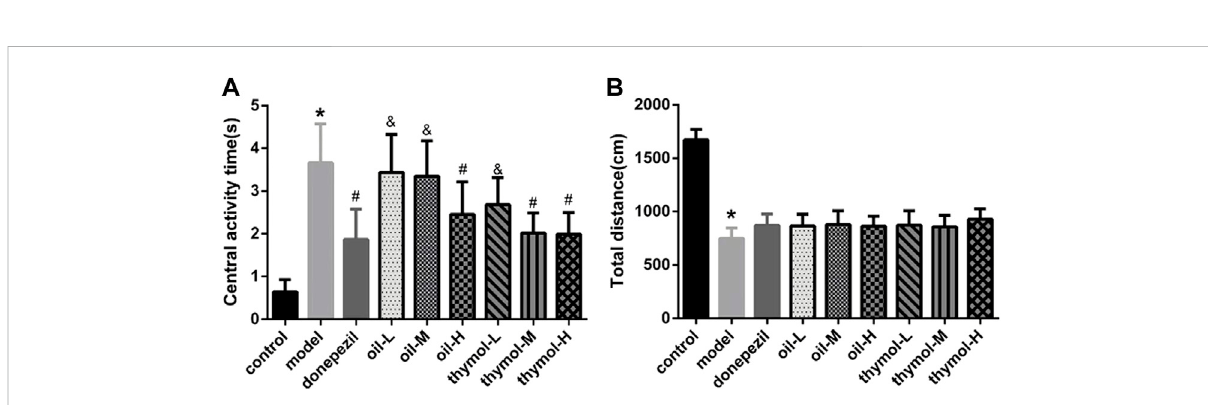
FIGURE 2 Comparison of step-through test of mice in each group. (A) Comparison of escape latency; (B) Comparison of error times; Compared with control group * p < 0.05; compared with model group # p < 0.05; compared with donepezil group & p < 0.05 n =